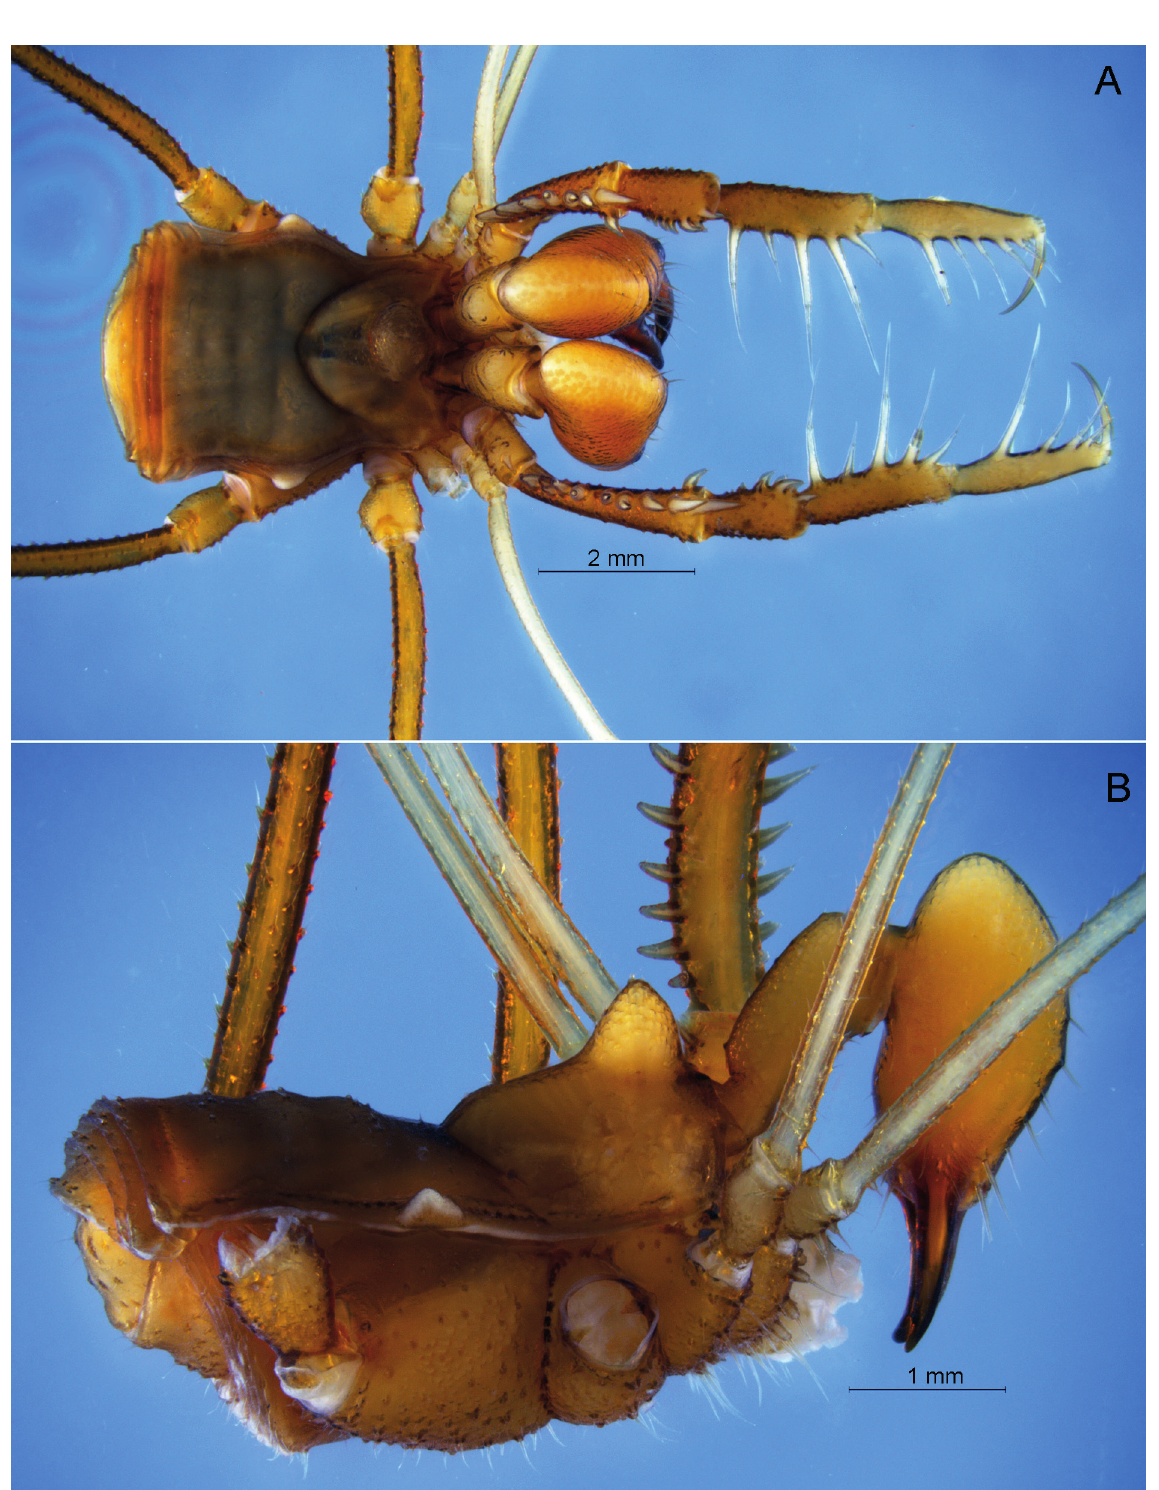
Fig. 4. Troglostygnopsis kalebi sp. nov., ♂, holotype (CNAN-T0850). A . Dorsal view. B . Lateral